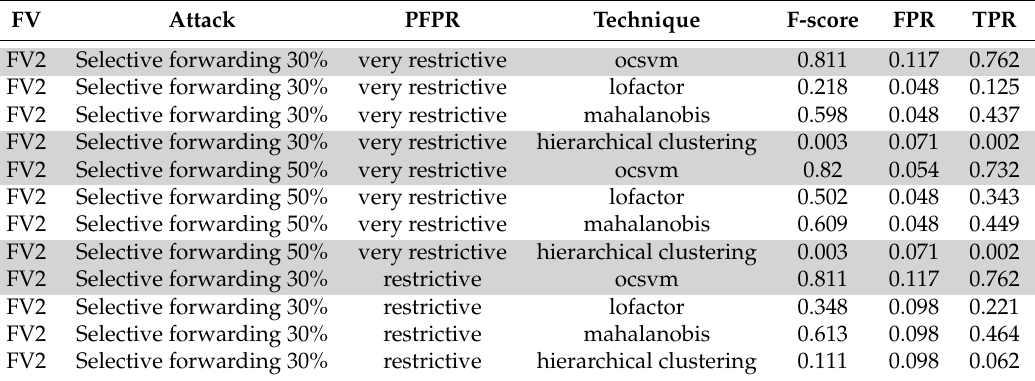
Table 3. Results of several cases exceeding the PFPR. Cases where PFPR<FPR are highlighted. FV Attack PFPR Technique F-score very restrictive very restrictive lofactor very restrictive hierarchical